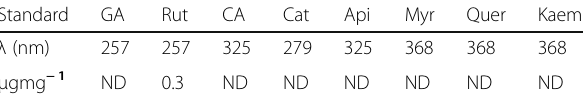
λ (nm) represents wavelength in nanometer while μ g mg − 1 represents the quantity of polyphenol in microgram per milligram of the extract. ND: Not Detected, GA: Gallic Acid, Rut: Rutin, CA: Caffeic Acid, Cat: Catechin, Api: Apigenin, Myr: Myrecetin, Quer: Quercetin, Kaem: